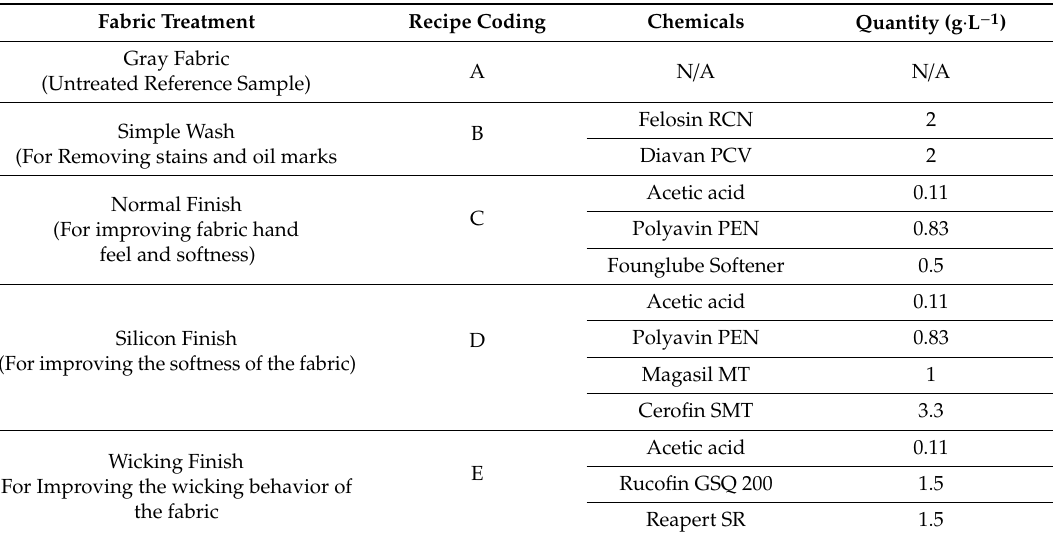
Table 2. Recipe Coding of Di ff erent